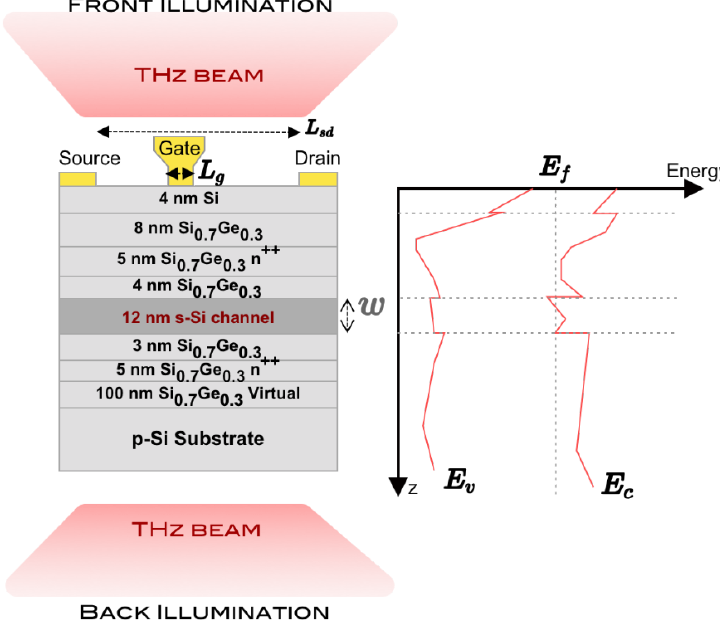
Figure 1. Left: Schematic cross section of the transistor under study. Front and back illumination configurations are highlighted by showing the respective incident THz beams in each configuration. Right: Vertical distribution of the energy band diagram under the gate at equilibrium showing the Fermi level. The double-deck supply (two unstrained n ++ Si 0.7 Ge 0.3 highly doped layers) sandwiching the 12 nm-thick strained silicon layer (region of thickness w highlighted in dark grey and surrounded by two nominally undoped spacer layers) generates a double quantum well inside de channel [15,19].